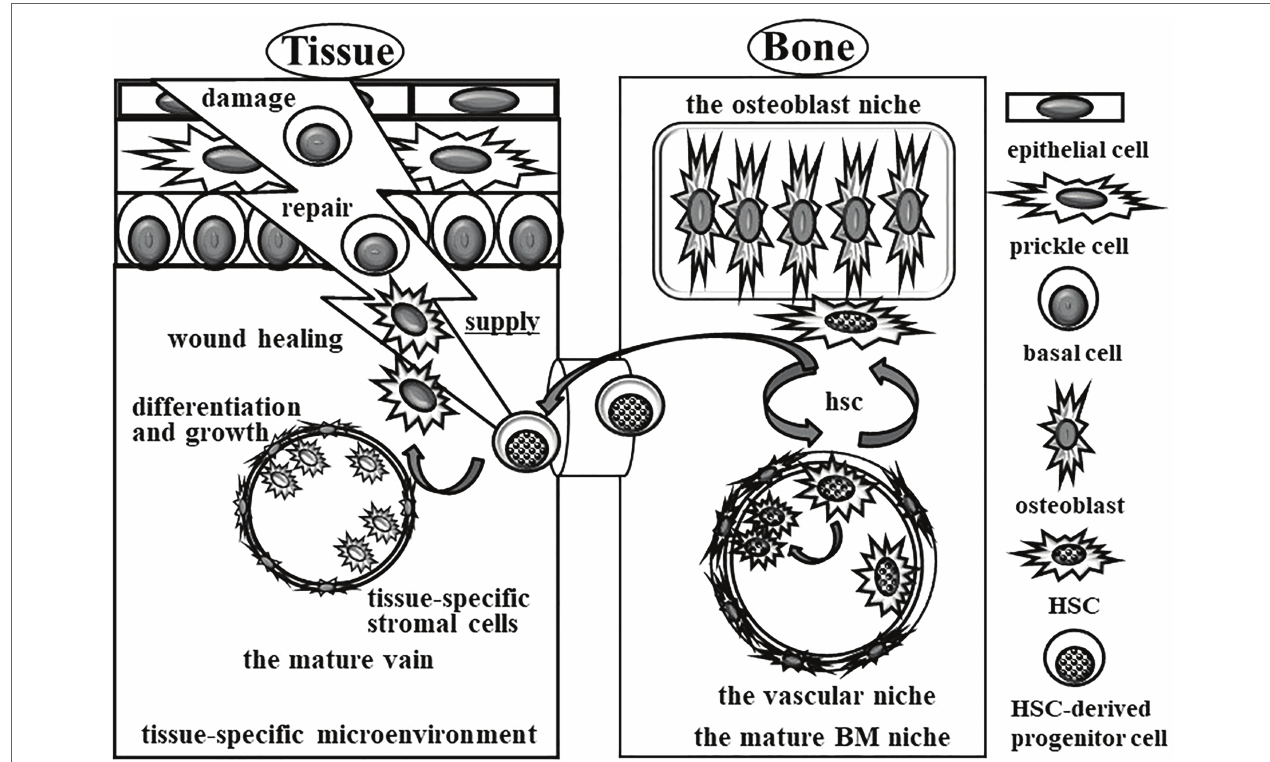
FIGURE 2 | Schematic image of complete wound healing for acute inflammation by the mature immune system without changing the tissue-specific microenvironment. Acute inflammation is rescued by the mature immune system without changing the microenvironment. The repair tools are supplied from blood vessels. After treatment of acute inflammation cued by immune cells, all of the repair tools, including immune cells, are cleared by phagocytic macrophages. After that, the HSC-derived precursor cells from BM migrate into the acute inflammation site to rebuild the damaged